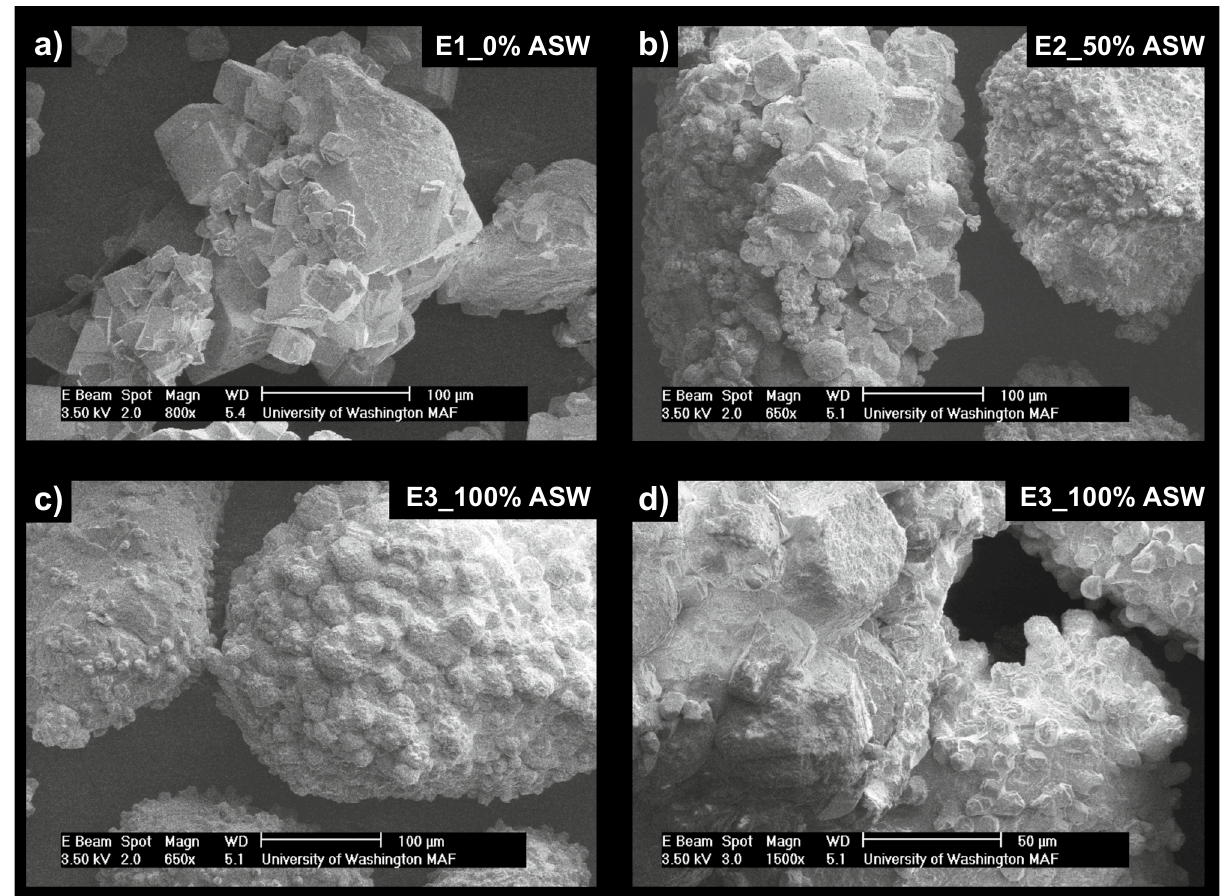
Figure 3. SEM images of precipitates from ( a ) 0% ASW, ( b ) 50% ASW, and ( c, d ) 100% ASW